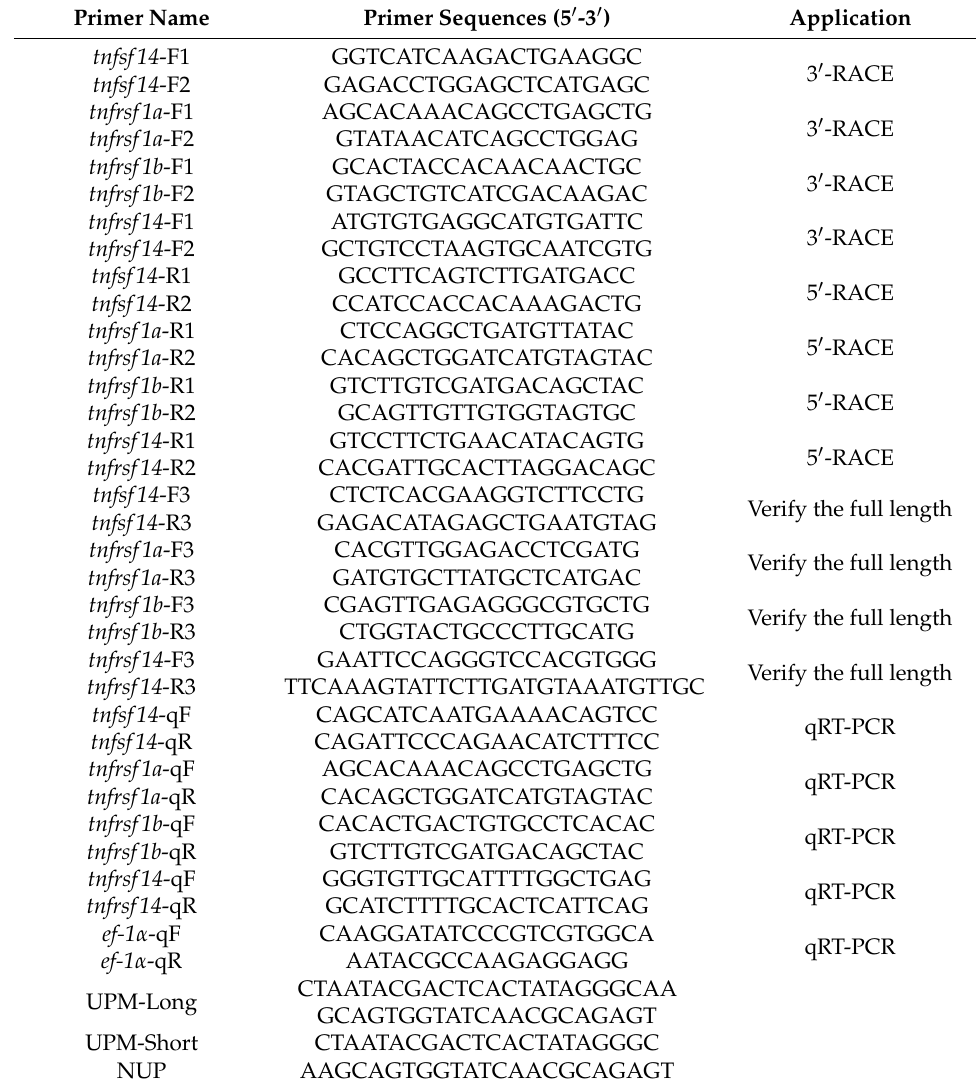
Table 1. Primers used in this